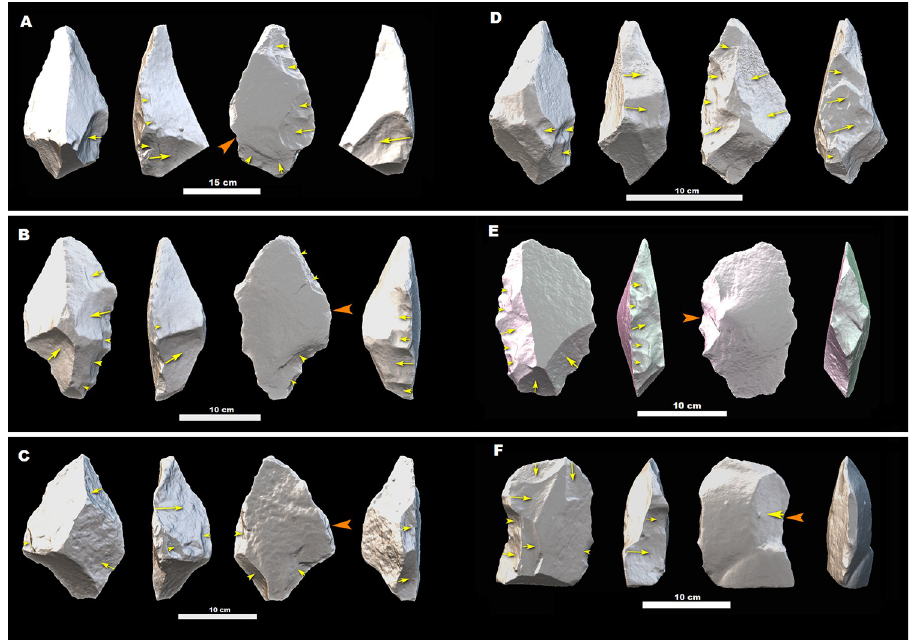
Fig 8. Crude LCTs (A–C), Pick (D), and Large scrapers/knives (E and F) from MW2-L3. (A) is made on special side- struck flake, (B), (C), (E) and (F) are on side-struck flake, and the blank of the pick (D) is indeterminate. All of the tools are made on glassy ignimbrite. Orange arrows indicate the direction of flaking of the blanks, while yellow arrows indicate the direction of removals during shaping phases.